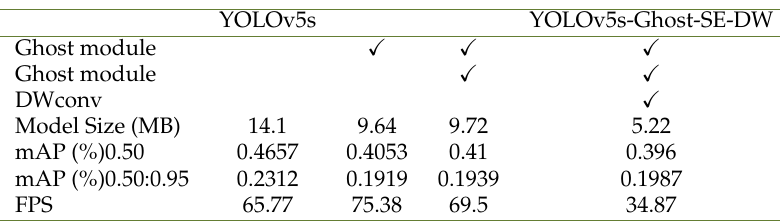
Table 3. Performance results of different modules on the BDD100K dataset YOLOv5s YOLOv5s-Ghost-SE-DW